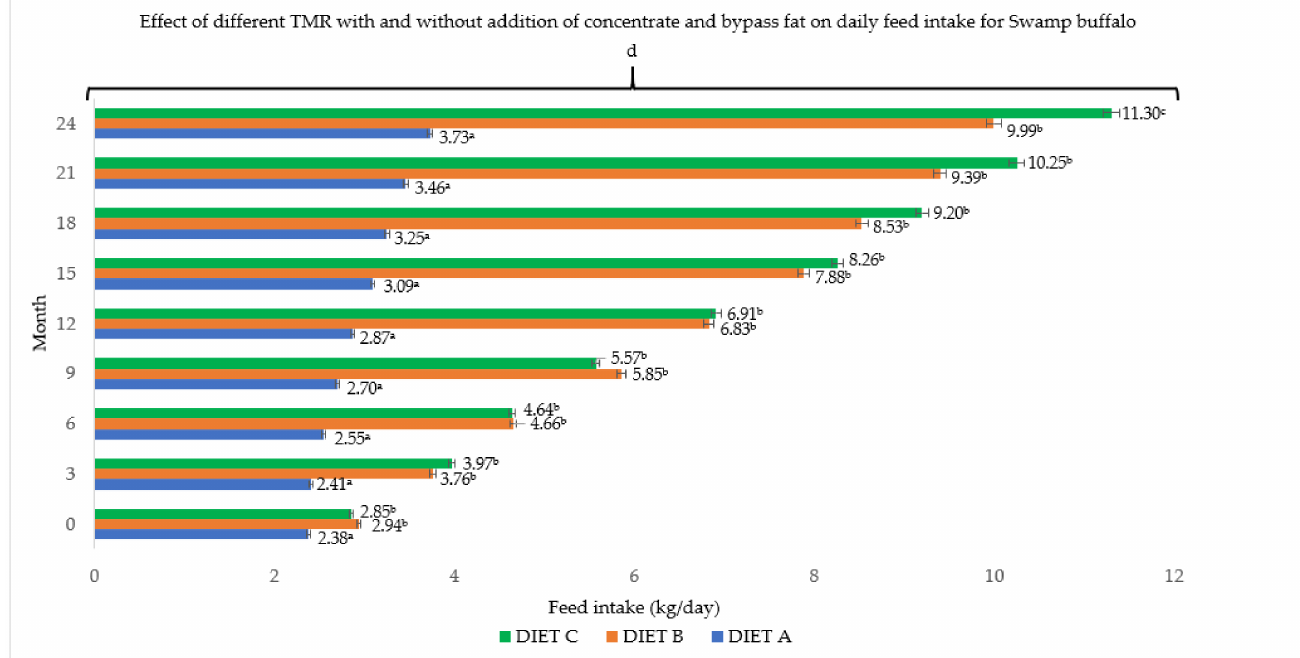
Figure 2. Effect of different TMR with and without addition of concentrate and bypass fat on daily feed intake for Swamp buffalo. Diet A (control)—(100% Brachiaria decumbens) ; Diet B—(70% Brachiaria decumbens + 30% concentrate); Diet C—(70% Brachiaria decumbens + 26% concentrate + 4% bypass fat); the values are presented as mean; a,b,c different superscripts indicate significant difference on daily feed intake for Swamp buffalo at p < 0.05; d indicating significant ( p < 0.05) difference comparing between months and feed